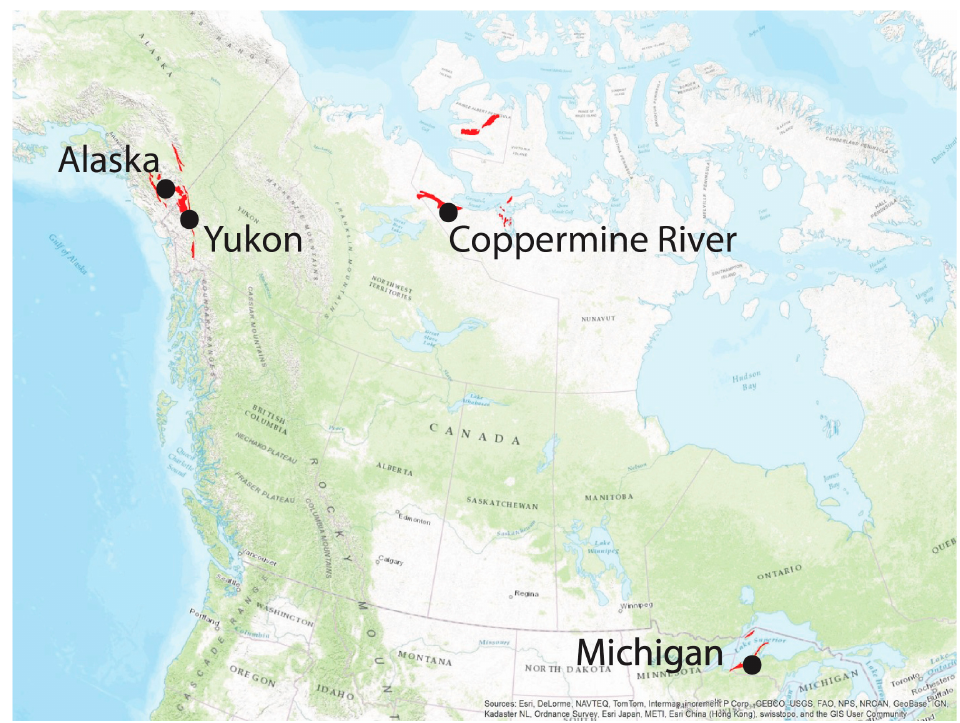
Figure 1. Map showing copper-bearing formations (red areas) associated with native copper sources. Dots correspond to location of samples used in this study. Table 1. Results of Native Copper LIA.